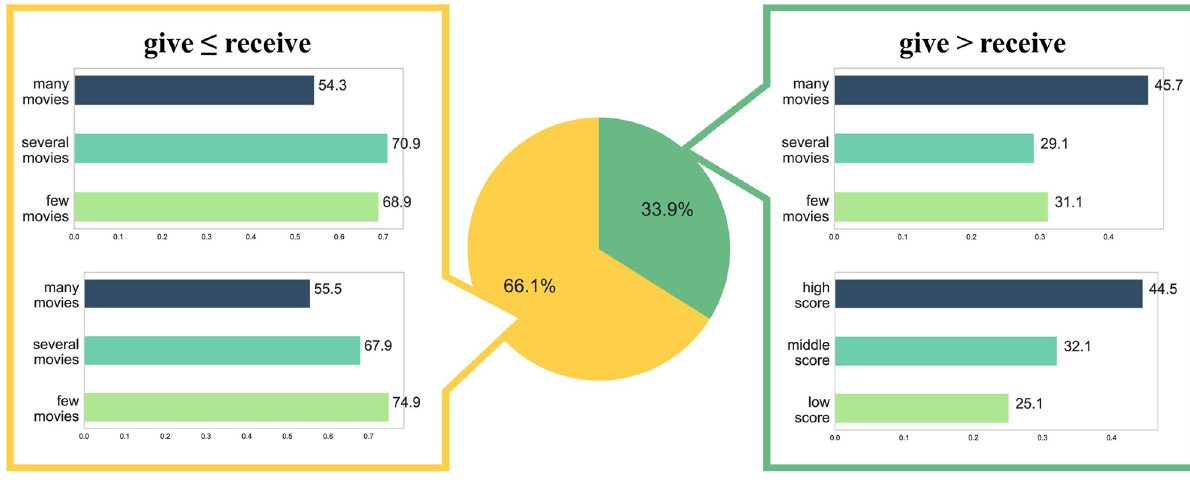
Fig 4. Analysis of asymmetric